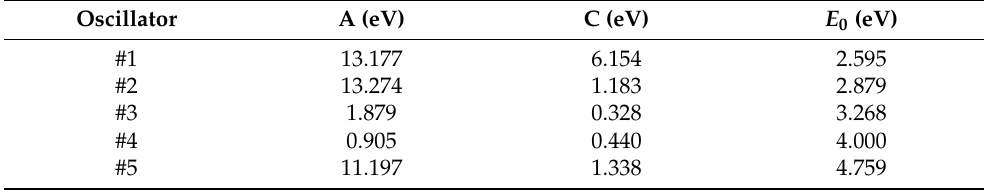
Table 1. Tauc–Lorentz parameters of the oscillators (excitons) with ε ∞ = 1.766 and E g = 0.137 eV used to describe dielectric function of PtS 2 . Tabulated optical constants are collected in Table